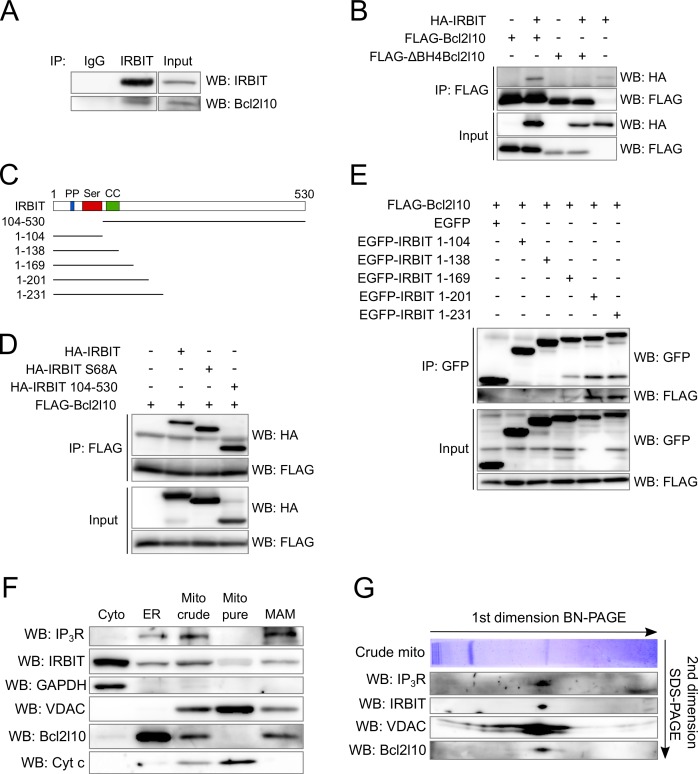
IRBIT and Bcl2l10 interact together and belong to a protein complex in MAM.(A) Western blot of IP between endogenous IRBIT and endogenous Bcl2l10. Western blot representative of three independent experiments. (B) Western blot of IP between HA-IRBIT and FLAG-Bcl2l10 or FLAG-∆BH4Bcl2l10. Western blot representative of three independent experiments. (C) Schematic representation of full-length IRBIT and of the deletion mutants used. PP – Protein phosphatase-1 binding site; Ser –Serine-rich region; CC – Coiled-coil domain. (D) Western blot of IP between FLAG-Bcl2l10 and HA-IRBIT or the indicated HA-tagged mutants of IRBIT. Western blot representative of three independent experiments. (E) Western blot of IP between FLAG-Bcl2l10 and EGFP or the indicated mutants of IRBIT in fusion with EGFP. (F) Protein components of subcellular fractions prepared from HeLa cells revealed by Western blot analysis. Cyto – Cytosol; ER – Endoplasmic reticulum; Mito crude – crude mitochondria which is composed of pure mitochondria (Mito Pure) and mitochondria-associated membranes (MAM). Western blot representative of three independent experiments. (G) Blue-native (BN) and SDS-PAGE 2D separation of a crude mitochondria fraction prepared from HeLa cells. Second dimension SDS-PAGE was analyzed by Western blot. Western blot representative of two independent experiments.